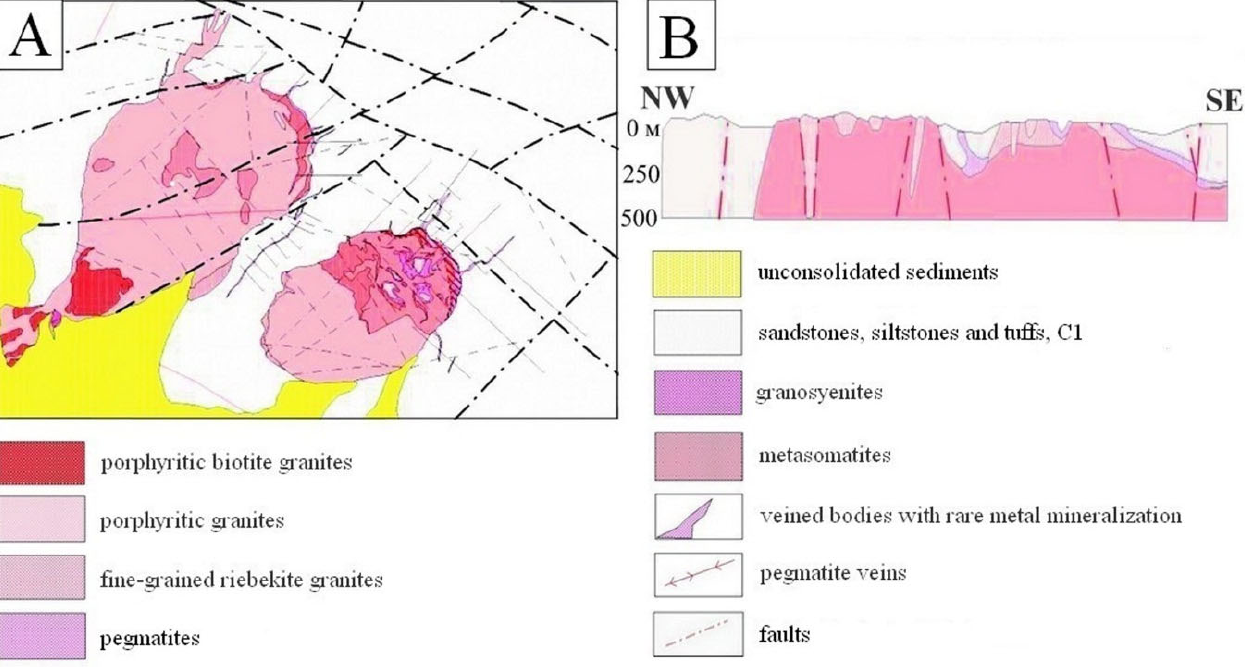
Figure 12. Geological map ( A ) and cross section ( B ) of the Verkhnee Espe deposit [67]. Abundant alkaline granites in the area were metasomatized at the postmagmatic stage, together with the country rocks. Metasomatic reactions provided Li, Rb, Y, Nb, Zr, and REE inputs into the rocks [68]. Mineral layers or veins are mainly localized along low-angle intrusion margins [69]. Main metallic minerals are zircon, pyrochlore, gagarinite, thorite, etc., as well as less abundant cassiterite, columbite, phenacite, gadolinite, etc. The contents of rare metals increase upward from the intrusion center.